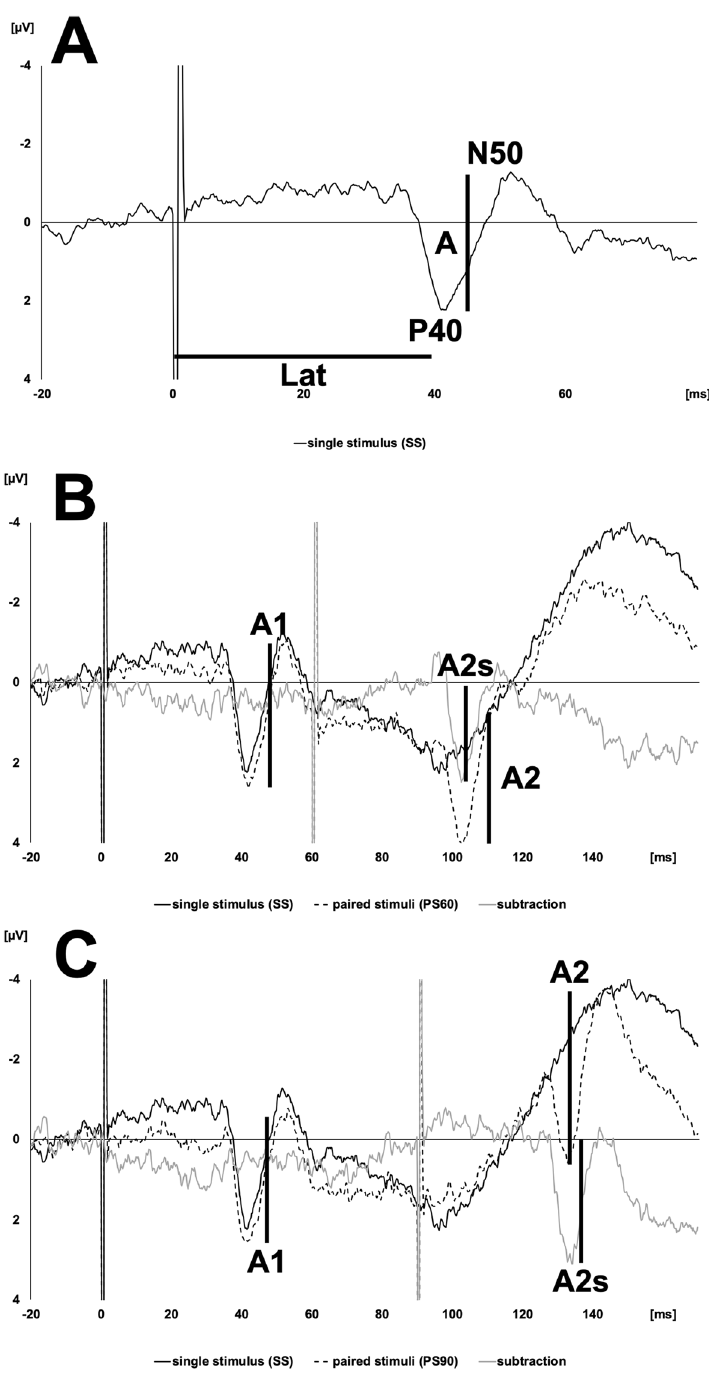
Figure 2. ( A ) Example of a single stimulation tibial nerve somatosensory evoked potential recorded over Cz’. “A” shows the amplitude (µV) and “Lat” the latency (ms) of the P40-N50 peak. ( B / C ) Examples of a paired stimulation tibial nerve somatosensory evoked potentials recorded over Cz’ with an interstimulus interval of 60 (PS60; B ) and 90 (PS90; C ) ms. “A1” shows the amplitude (P40-N50; µV) of the first peak as “A2” shows the amplitude of the second peak. “A2s” displays the amplitude of the second peak after linear subtraction of the response to a single stimulation. y-axis: amplitude [µV]. x-axis: time